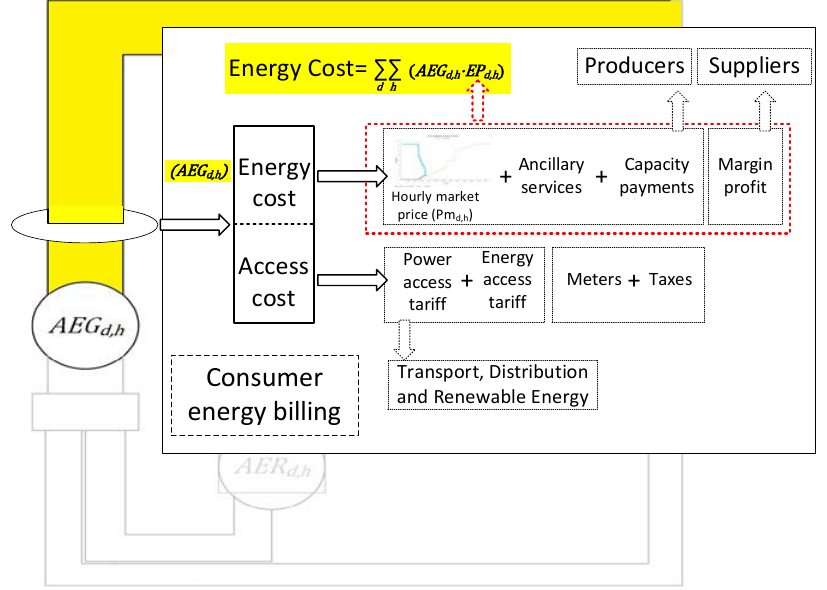
Figure 4. Representation of the applied consumer’s billing structure. Source: self-elaboration.